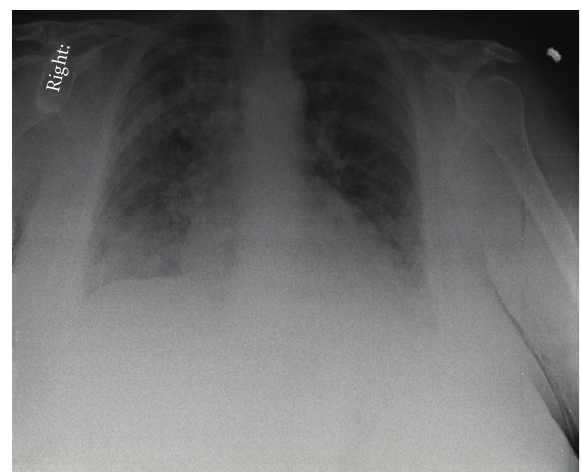
Figure 1: Chest radiograph showed acute bilateral pulmonary infiltration, more confluent in the areas of the right upper and bilateral lower